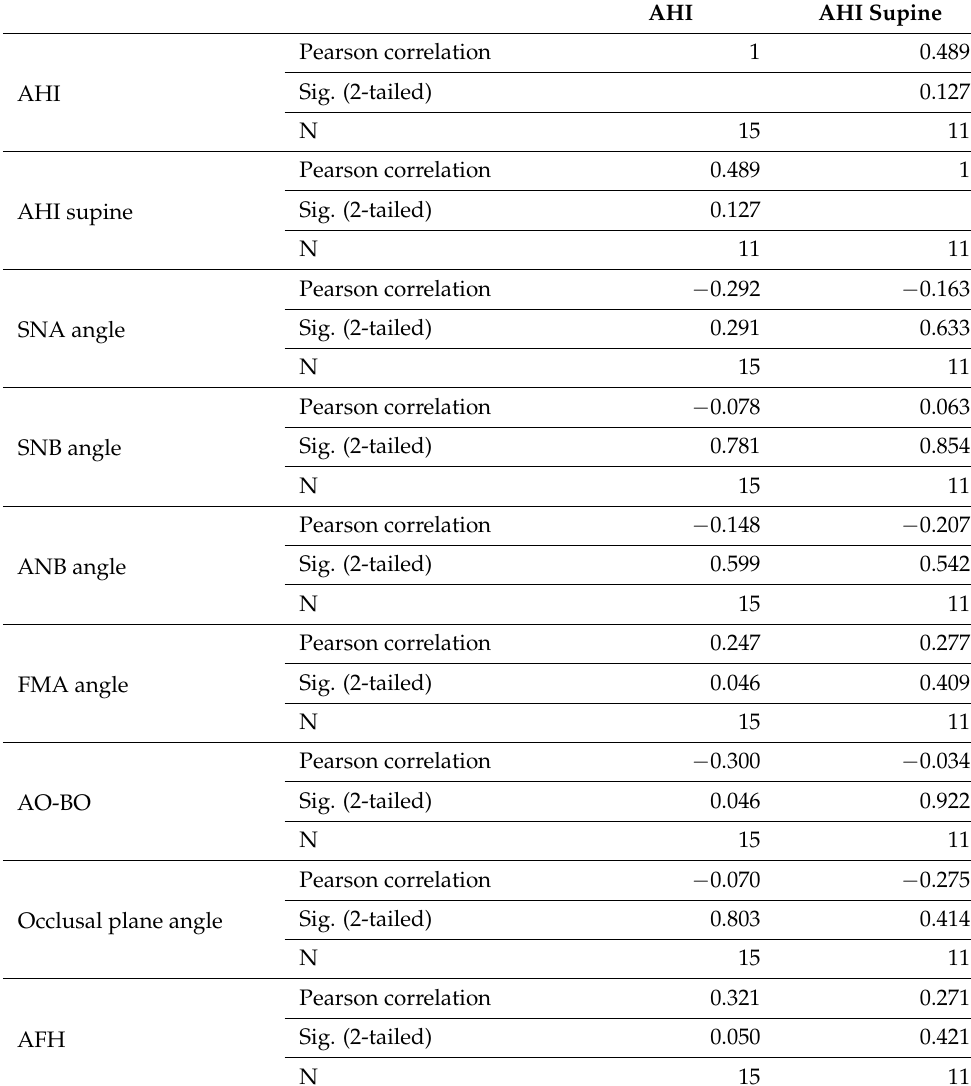
Figure 5. Scatter plot defining the correlation between AHI and SPAS. r = − 0.28. Table 6. Pearson correlation analysis between cephalometric variables and OSA parameters (AHI, AHI supine) in overweight group (BMI > 25).